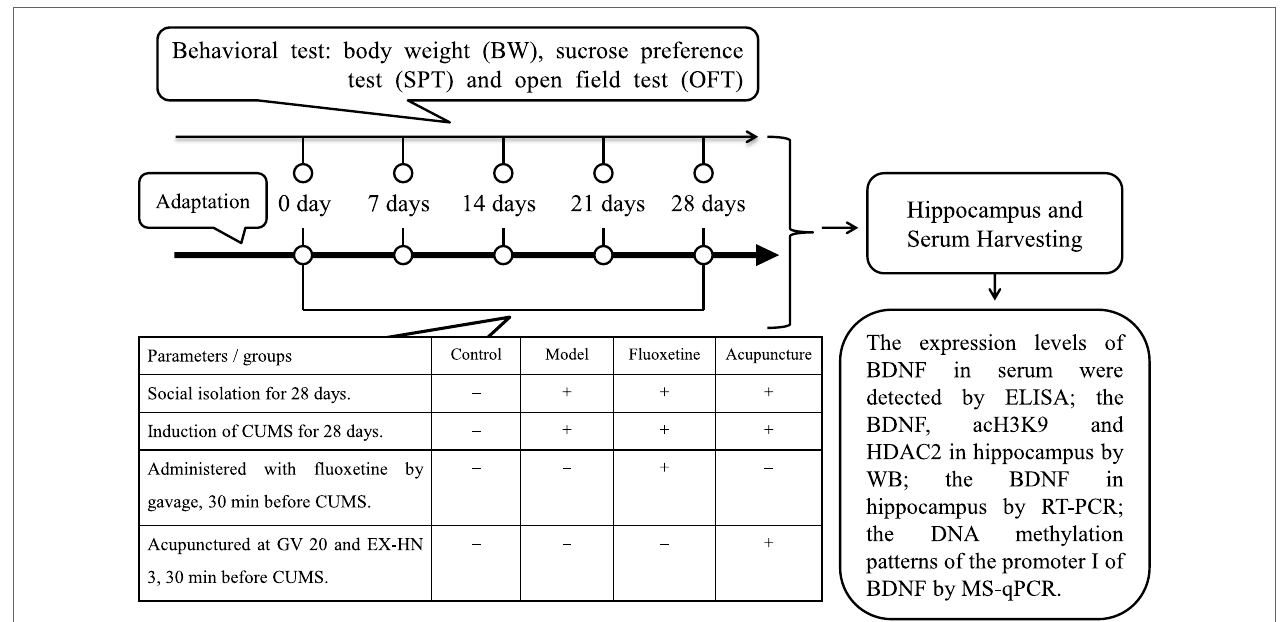
FigUre 1 | Experimental procedures. CUMS, chronic unpredicted mild stress; BDNF, brain-derived neurotrophic factor; acH3K9, acetylation levels in histone H3 lysine 9; HDAC2, histone deacetylase 2; RT-polymerase chain reaction (PCR), reverse transcription-polymerase chain reaction; MS-qPCR, methylation-specific quantitative polymerase chain reaction; BW, body weight; SPT, sucrose preference test; OFT, open field test.